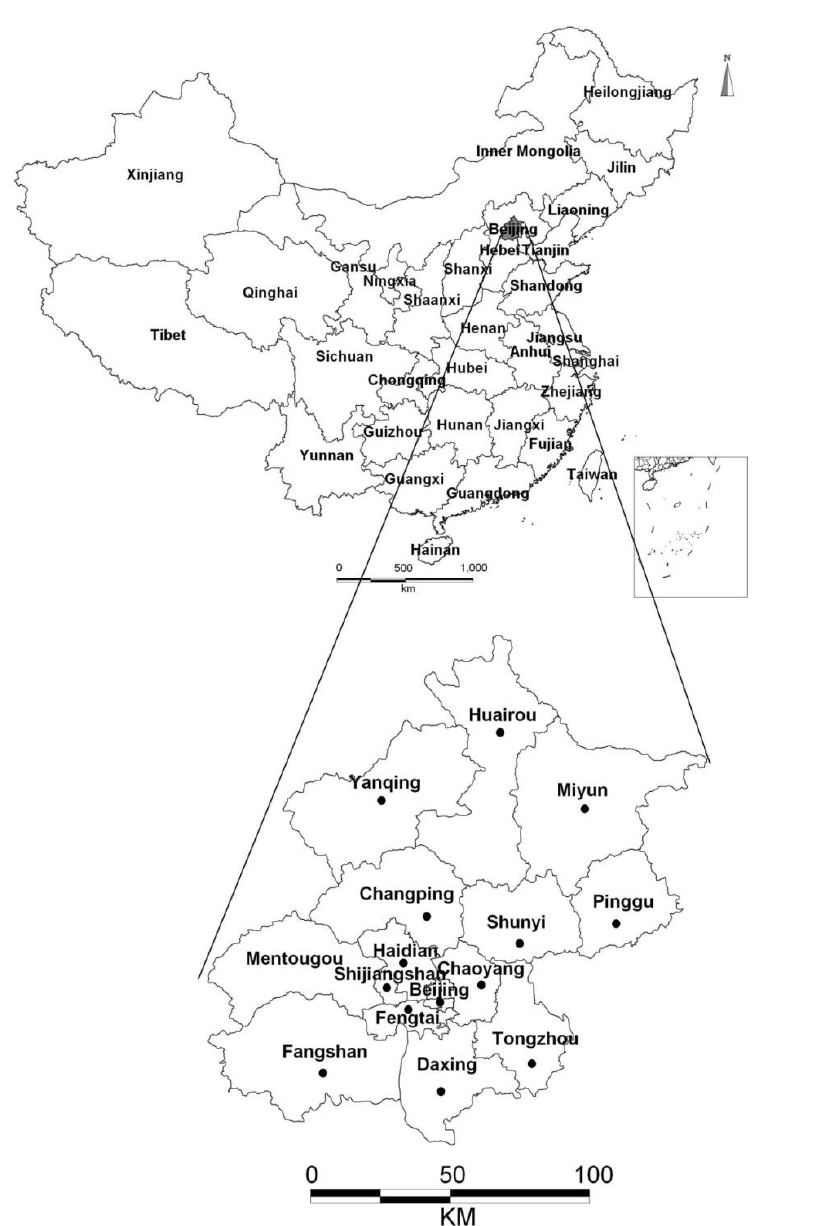
Figure 1. Location of Beijing City. The insets are zooms of the city map where the dots represent the sampling